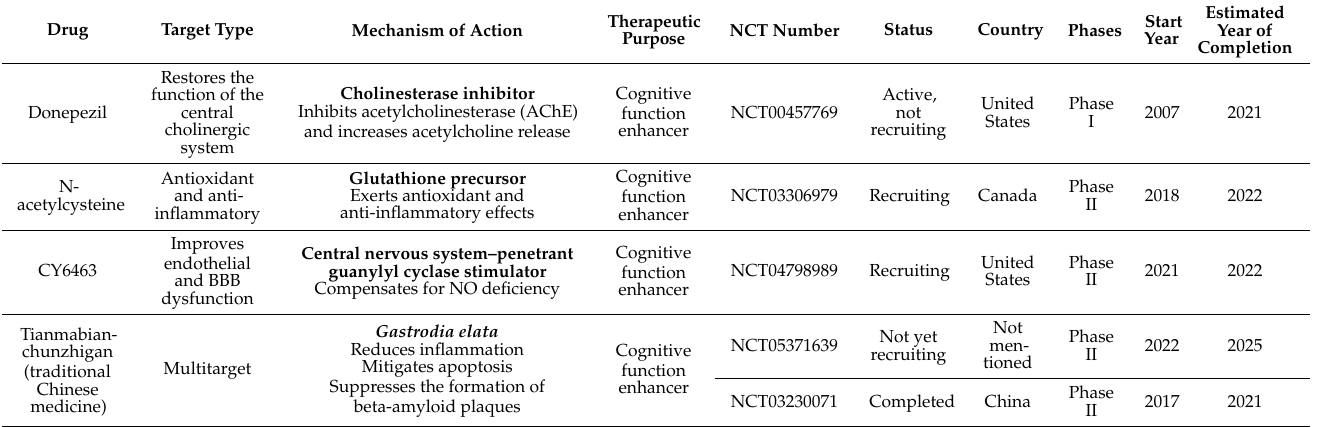
Table 2. Therapeutic agents for VCI and VaD treatment in phase I/II